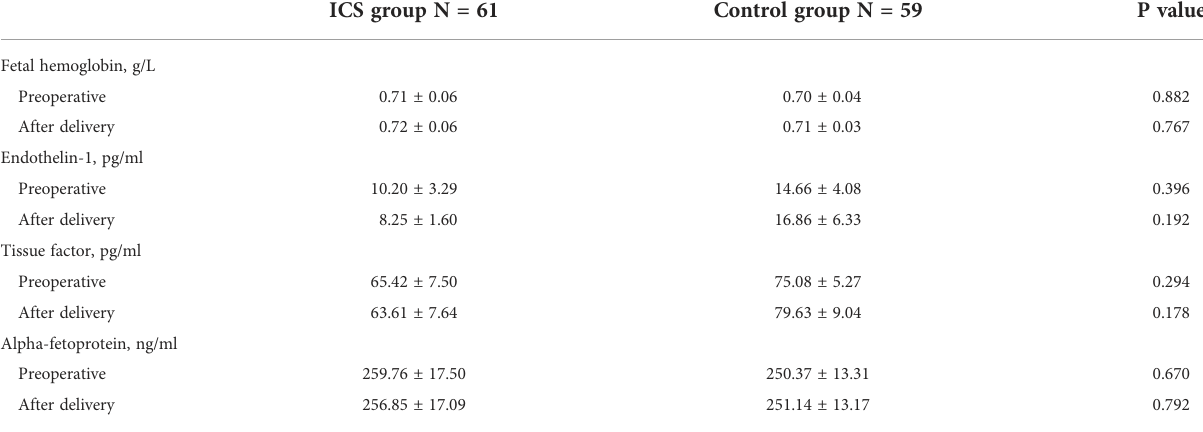
TABLE 4 Comparison of plasma fetal hemoglobin, endothelin-1, tissue factor, and alpha-fetoprotein between the two groups before and after child delivery.